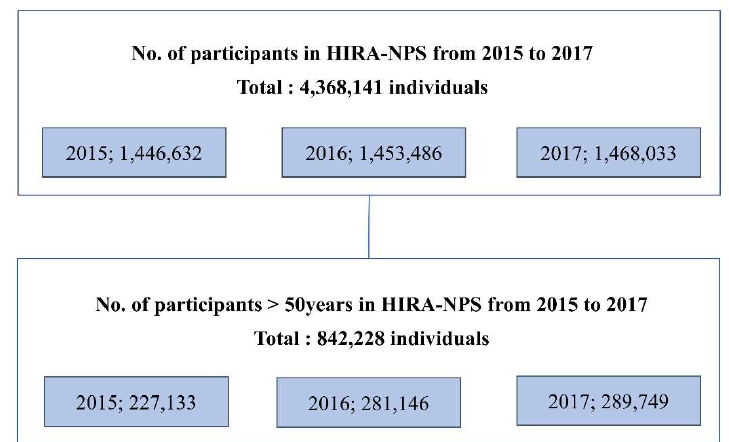
Figure 1. Study participants from the Health Insurance Review and Assessment Service National Patient Sample (HIRA-NPS) from 2015 to